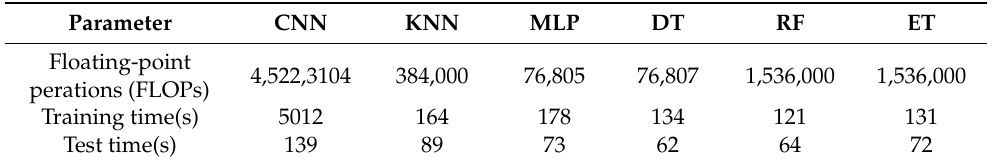
Table 5. Computational costs and complexities for the CNN, KNN, MLP, DT, RF, and ET